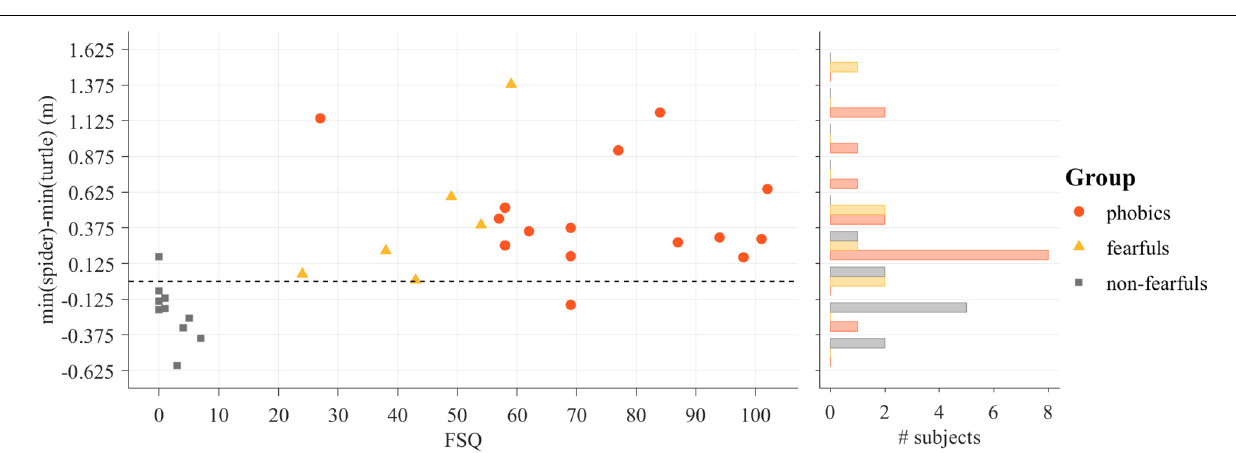
η 2 = 0.21, η 2 = 0.20], nor a stimulus effect [ F (2,24) = p G